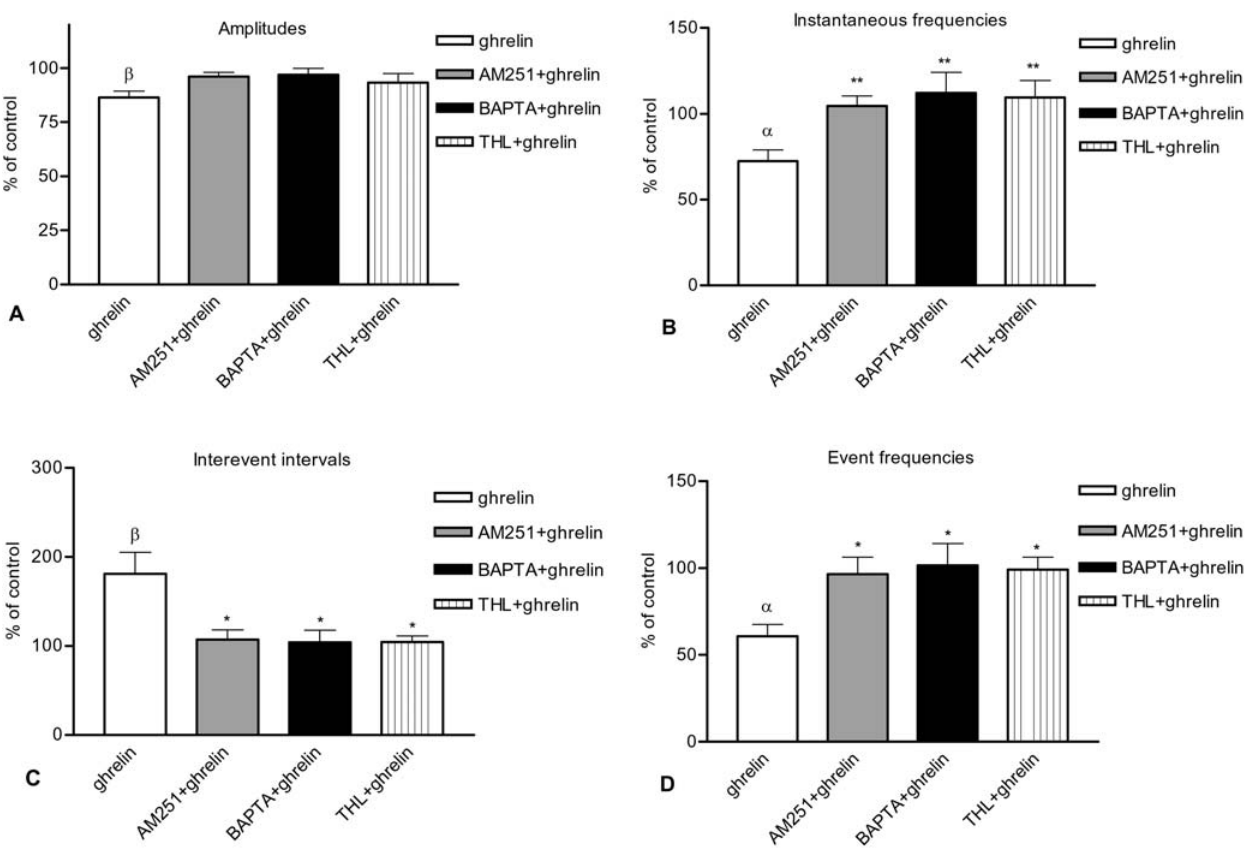
Figure 3. Changes of various parameters of mEPSCs [(A) amplitude, (B) instantaneous frequency, (C) interevent interval, (D) event frequency] elicited by ghrelin (as percentage of control), by AM251 + ghrelin (as percentage of AM251 alone), BAPTA + ghrelin (as percentage of BAPTA alone) and THL + ghrelin (as percentage of THL alone) in the parvocellular neurons. Application of ghrelin resulted in significant changes in all of these parameters whereas administration of AM251, BAPTA or THL eliminated the changes (Fig. 3A–D). All data shown as mean 6 SEM, a and b correspond to P , 0.05 and P , 0.01, respectively, and refer to the comparison of ghrelin vs. control. *P , 0.05 and **P , 0.01 correspond to the comparison between ghrelin vs. AM251 + ghrelin, ghrelin vs. BAPTA + ghrelin or ghrelin vs. THL + ghrelin